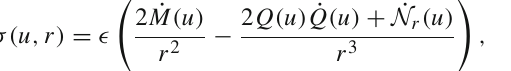
Fig. 5 The variation of D i versus typical values of the L , Q and N parameters in (48) for the dust background. We have set M = 1 with- out loss of generality in all these plots. The plots a – c represent the cases